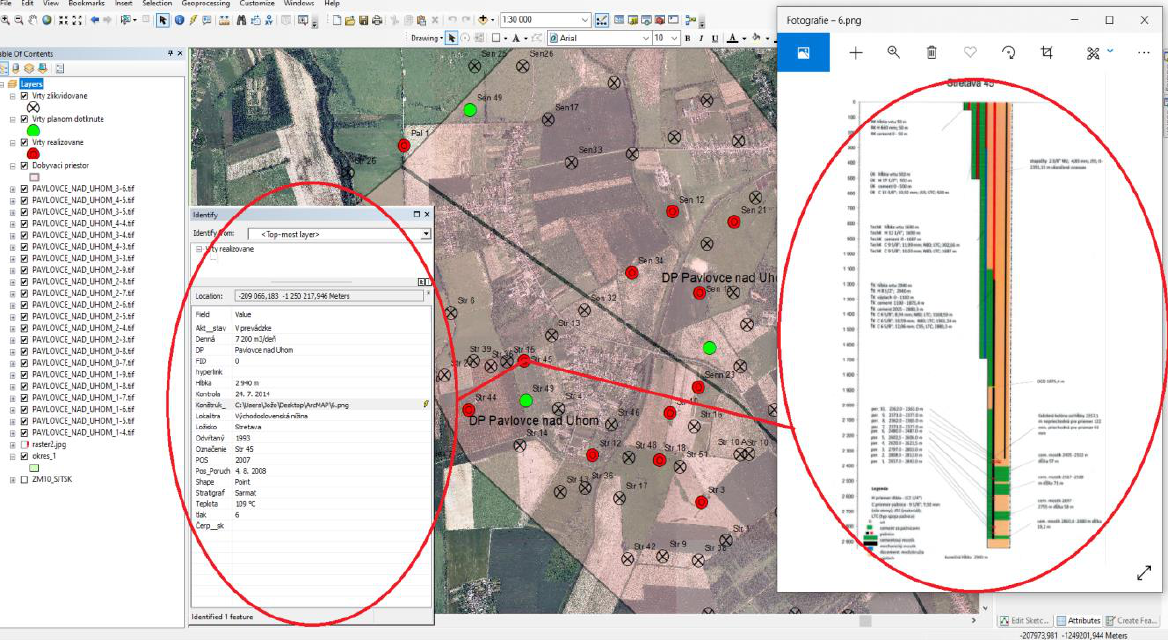
Figure 8. Preview of how to view basic information about the Stretava 45 well, (source: elaborated by authors).